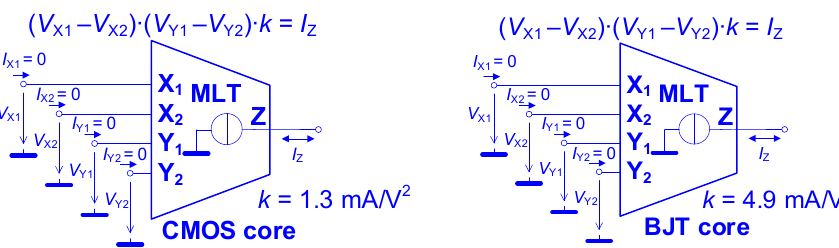
Figure 3. Schematic symbol and description of the ideal interterminal transfer relation of the voltage multiplier to the current output CMOS MLT (left) and BJT MLT (right).